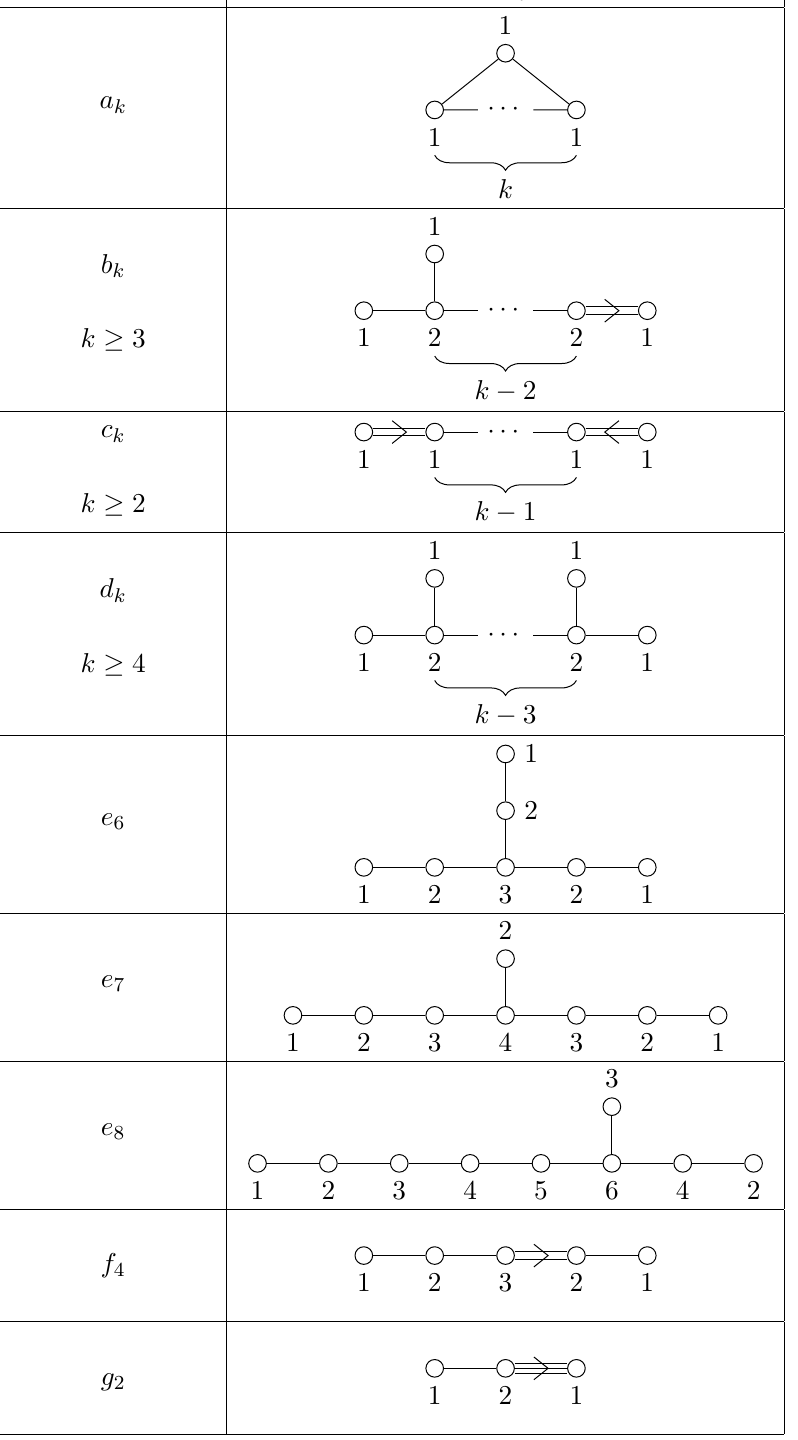
of the semi-simple Lie groups G , of the quivers k k ”. k